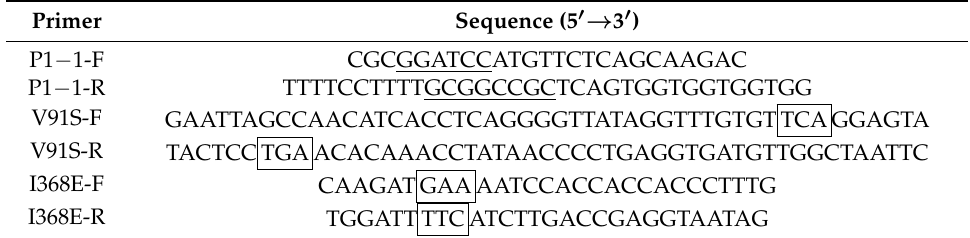
Table 2. The primers used for amplification of lxyl-p1 − 1 variants. Primer Sequence (5 (cid:48) → 3 (cid:48)